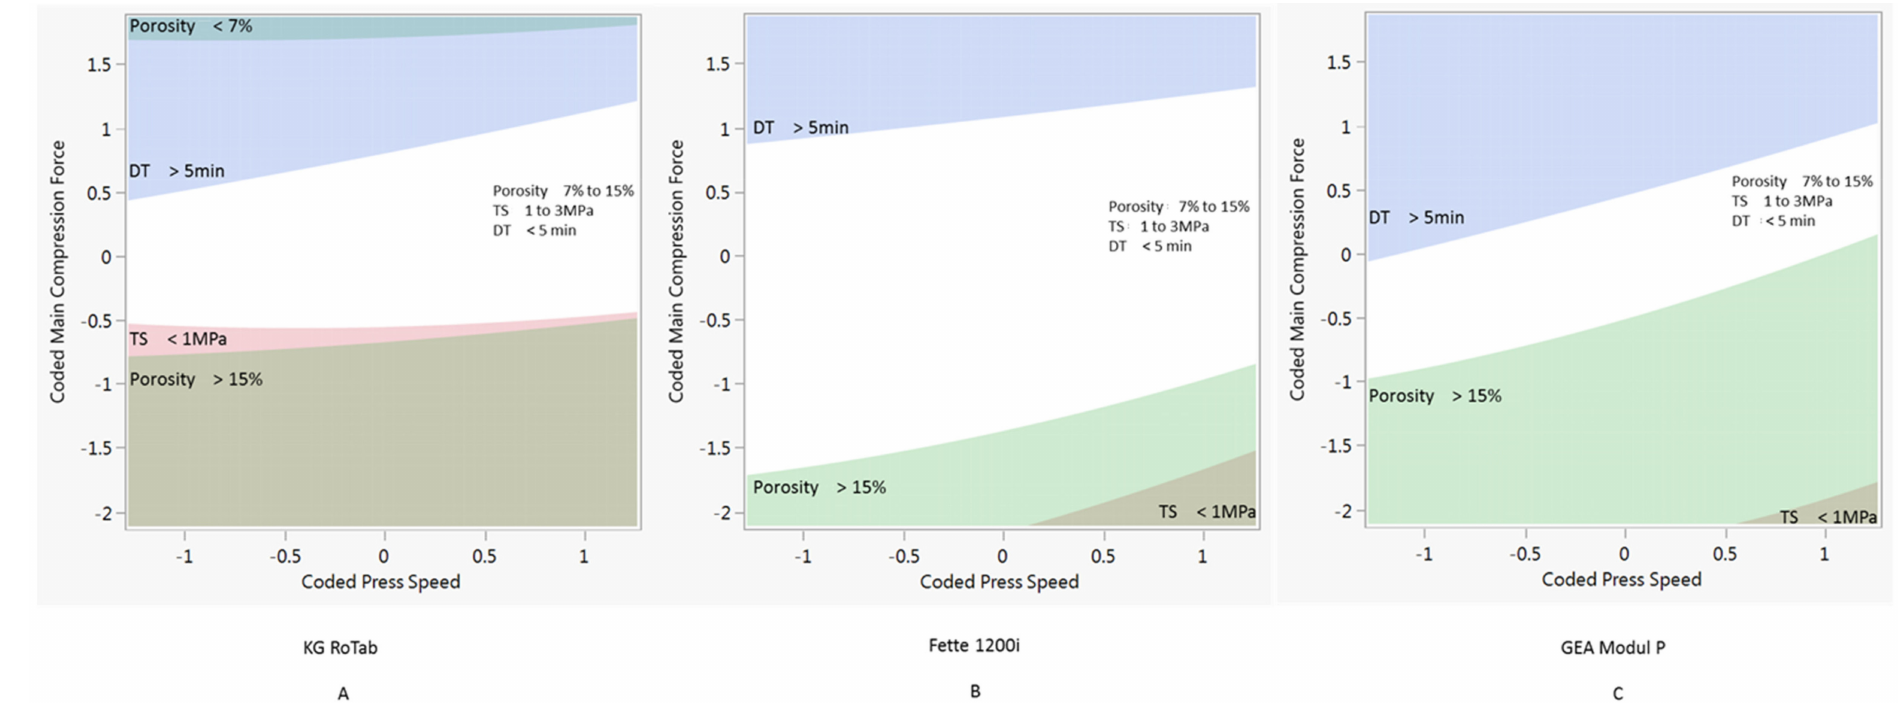
Figure 4. Two-dimensional contour profiles showing optimum process conditions for tablet tensile strength, porosity and disintegration time at optimum main compression force and press speed for formulation 2 on three tablet presses at a constant pre-compression force of 1 kN. ( A ) KG RoTab, ( B ) Fette 1200i and ( C ) Modul P. Coded main compression force and coded press speed values correspond to standardised units (Section 2.6). DT indicates disintegration time, and TS represents tensile strength. Regions of main compression force and press speed settings at which the tablets produced meet the target specifications of porosity 7% to 15%, tensile strength 1 to 3 MPa and disintegration time <15 min are in white. Regions of main compression force and press speed settings at which the tablets produced were outside the target specification are indicated by different shaded